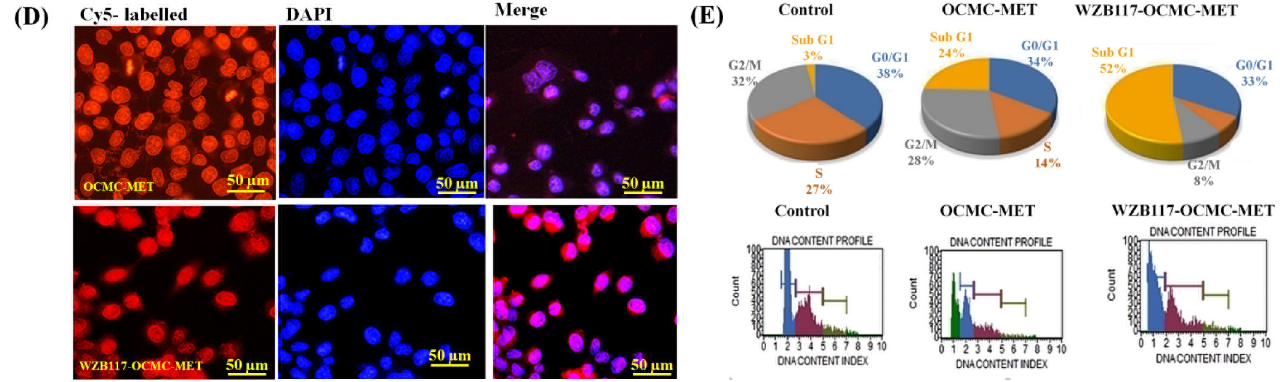
Figure 5. ( A ) DNA fragmentation of the MDA-MB-231 cell line using the MET-OCMC, WZB117, and WZB117-OCMC-MET. ( B ) Quantitative measurement of apoptosis by AnnexinV-FITC versus PI in MDA-MB-231 cells treated with OCMC-MET, WZB117, and WZB117-OCMC-MET. The data clearly indicate high late-phase apoptosis for the WZB117-OCMC-MET compared to OCMC-MET. ( C ) mTOR and BCL2 mediated apoptosis induced by WZB117-OCMC-MET compared with OCMC-MET. The OCMC-MET only downregulates the mTOR but does not alter the BCL2, whereas WZB117-OCMC-MET synergistically targets mTOR and BCL2. ( D ) Cellular internalization of WZB117-OCMC-MET and OCMC-MET in the MDA-MB-231 cancer cell line indicates that the complex was more effective in inter-cellular penetration due to the presence of WZB117 conjugation (50 µm scale bar). ( E ) Percentage population of the cancer cells and flow cytometric analysis at a different phase of the cell cycle.